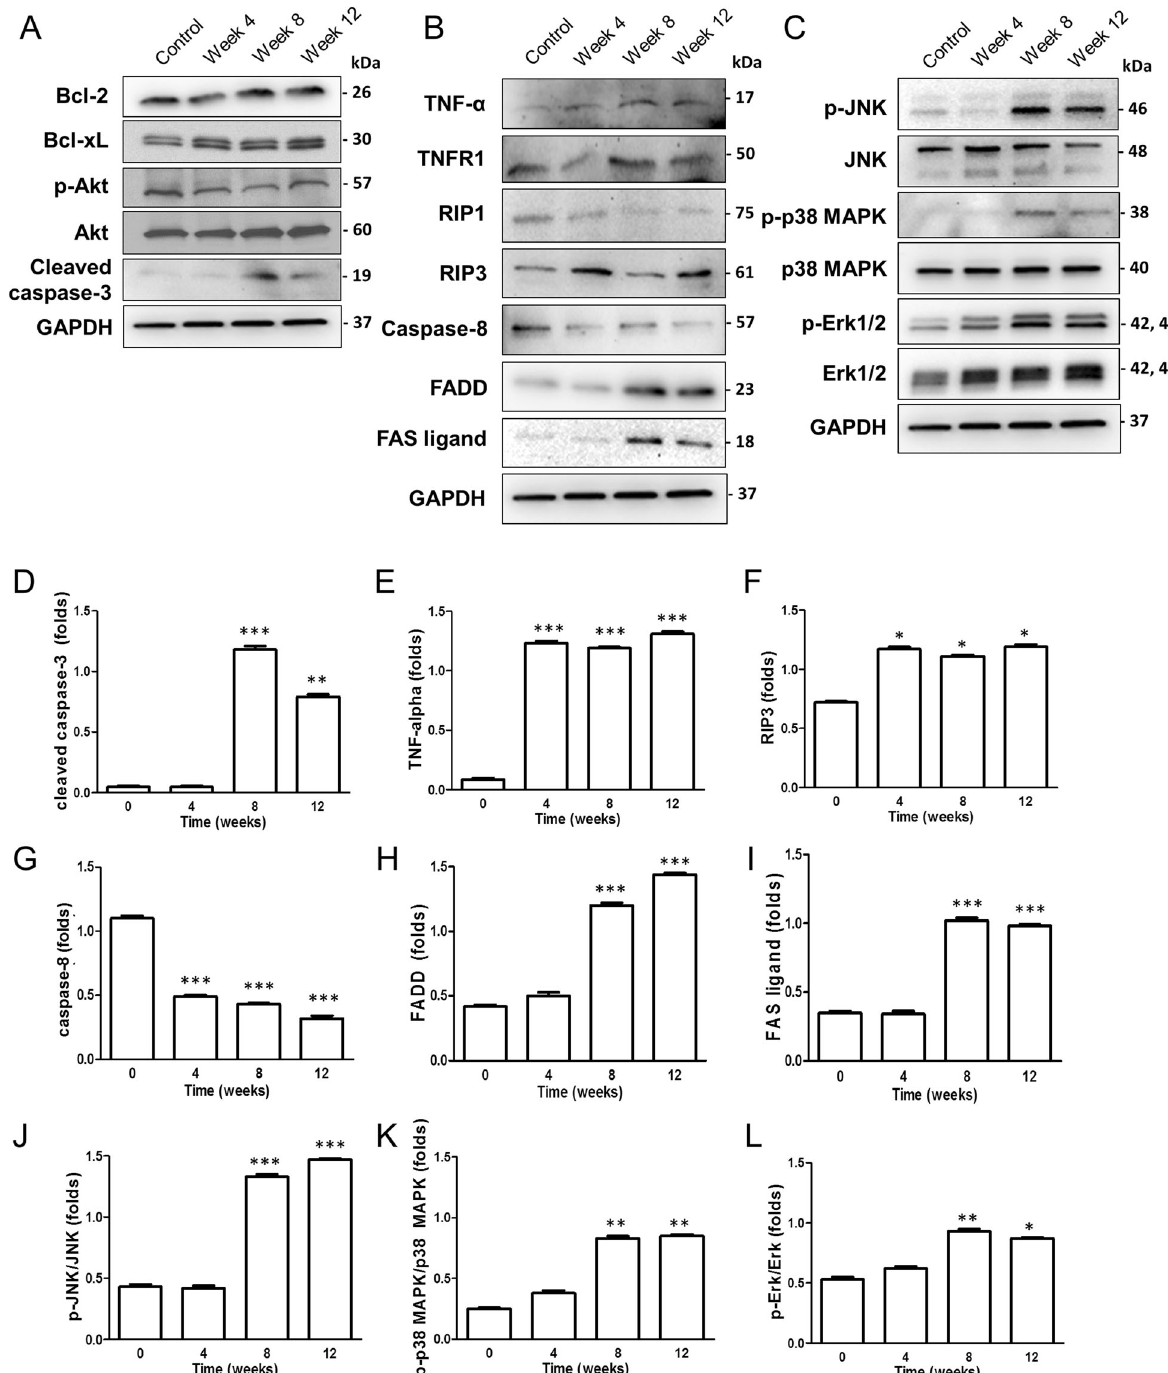
Fig. 5 Western blot analysis of molecular pathways involved in RGC death after systemic hypotension. Western blots of ( A ) intrinsic apoptotic, ( B ) extrinsic apoptotic and necroptotis, and ( C ) protein kinase signaling pathways. Involvement of ( D ) intrinsic apoptosis, ( E – F – G ) extrinsic apoptosis and necroptosis associated with tumor necrosis factor (TNF), and ( H , I ) Fas were signi fi cantly altered following induction of systemic hypotension. J – K – L Molecules associated with kinase signaling pathway were upregulated. For western blot analysis, n = 6 for control and n = 6 for systemic hypotension at each time period; total n = 96. Bar represents mean ± SD. Student ’ s t -test was used for statistical evaluation. * P < 0.05, ** P < 0.01, and *** P < 0.001 compared to the control. Microglia and astrocytes constitute glia in the central nervous expresses angiotensin II receptor, and the activated state of system, including the retina. Activated astroglial cells are termed microglia was affected by the angiotensin level. It is possible that damage-associated astroglia, since these cells play an important increased angiotensin II level in both hypertension and hypoten- role in in fl ammatory responses and associated cell death [38]. Since sion could explain the similar results of microglia activation.